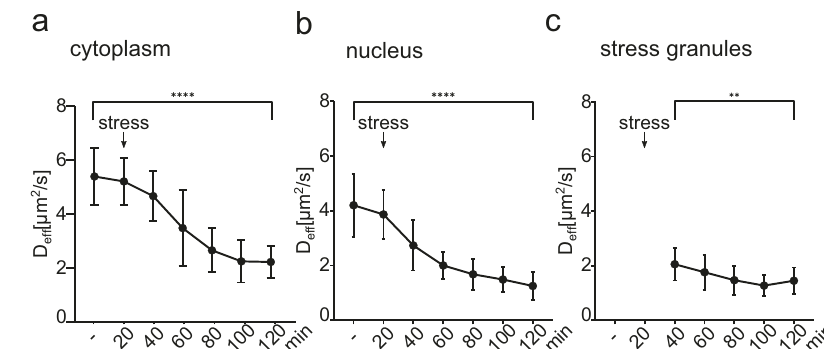
Fig. 5 | Region- and diffusion class speci fi c analysis of stress-induced TDP43 mobilityreduction. Stresstimecourseoftheeffectivediffusioncoef fi cientD eff for the TDP-43 Halo construct shown for the cytoplasm ( a ), the nucleus ( b ) and stress granules ( c ) (mean+STD, two-tailed Welch ’ s t -test, cytoplasm p -value=<0.0001,